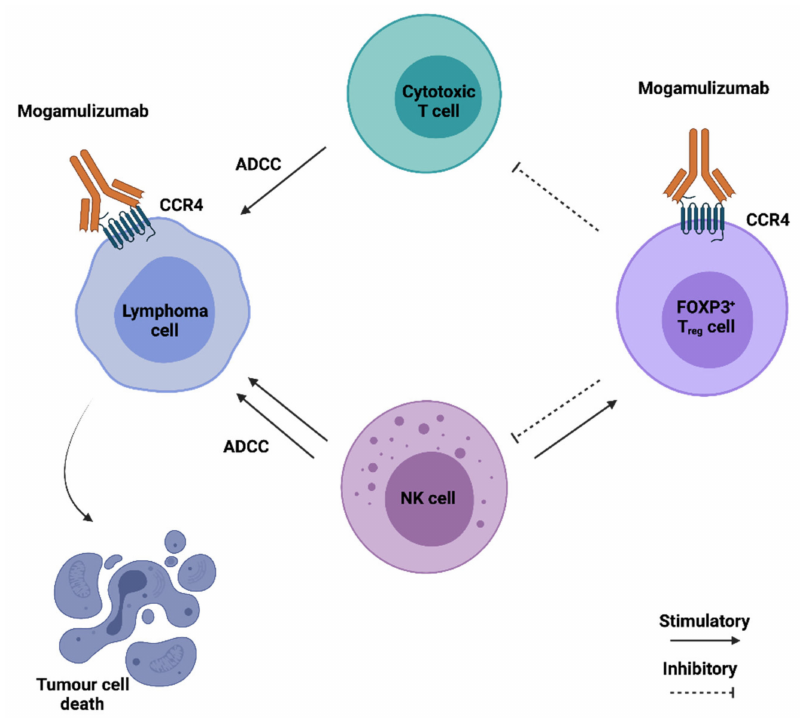
Figure 3. Anticancer therapeutic potential of Mogamulizumab (KW-0761). Mogamulizumab is shown in Figure 4. The antibody is prepared by glycoengineering and is defucosylated, enhancing the ADCC response promoted by cytotoxic T and NK cells. Elimination of CCR4 + T reg cells further enhances the immune response of cytotoxic T cells against the tumor